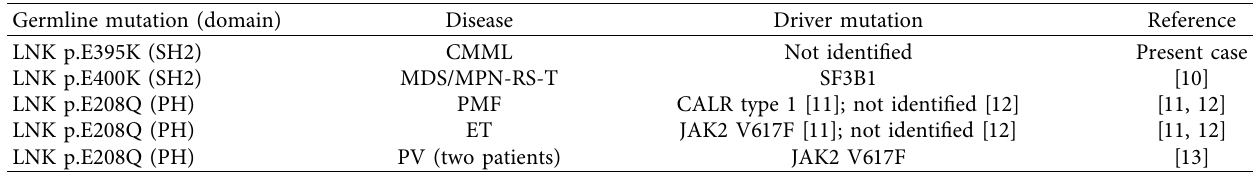
Table 1: Germline mutations in SH2B3, previously reported in